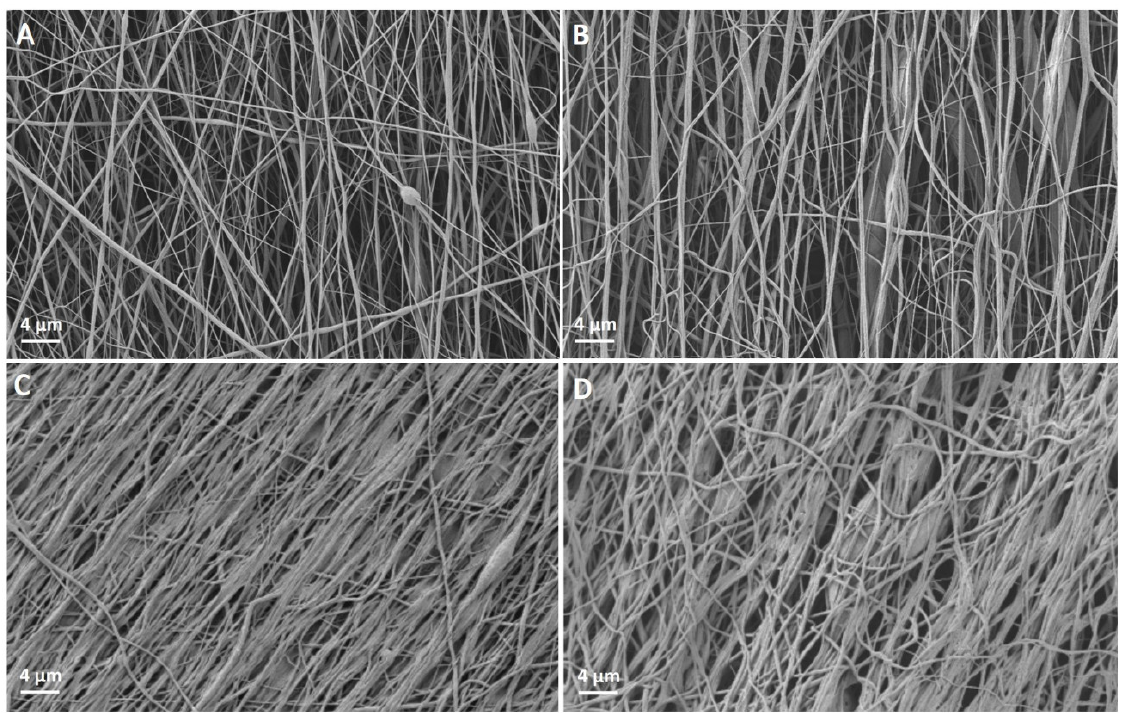
Figure 3. ( A ): PCL-collagen I-nanofibers before pretreatment. ( B ): PCL-collagen I-PEO-nanofibers before pretreatment. ( C ): PCL-collagen I-nanofibers after treatment with EtOH and PBS. ( D ): PCL- collagen I-PEO-nanofibers after treatment with EtOH and PBS.